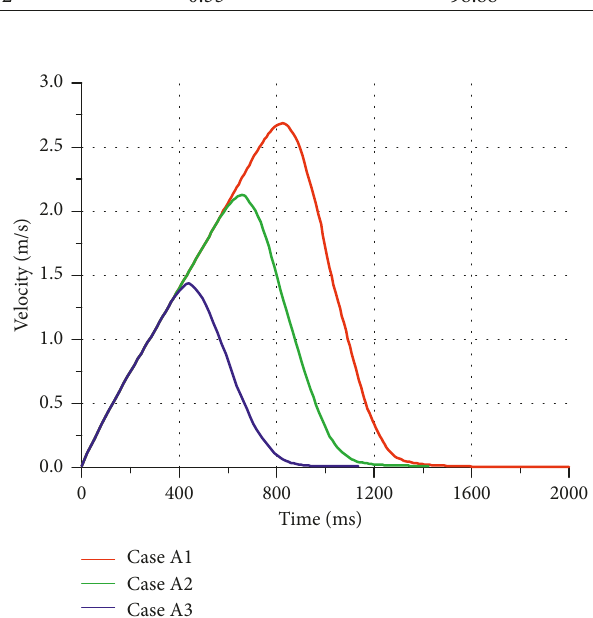
Figure 8: Time history of the granular flow velocity when the RNB was placed at different